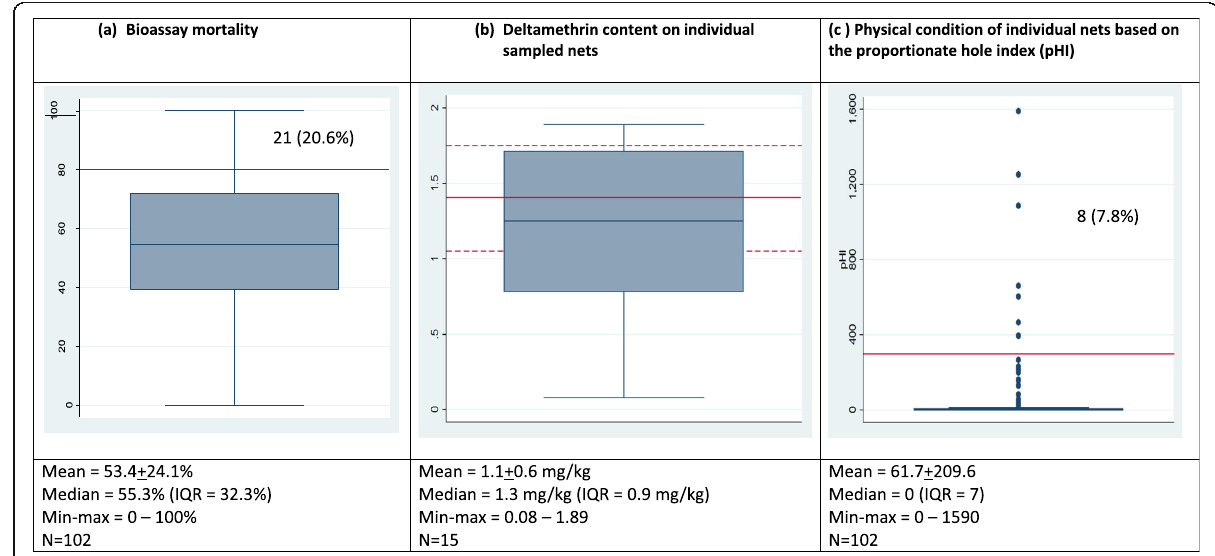
Fig. 5 Boxplot of Yorkool showing a median mortality, inter-quartile range (0.25 – 0.75), and max-min range. Full red line is the 80% mortality threshold ( a ), target dose of deltamethrin (full red line), and tolerance limits (± 25% of target dose, dashed lines ( b ), and ( c ) mean pHI threshold for replacement of nets (full red line). Nos (%) indicate the number of data points (percent) above the cutoff red